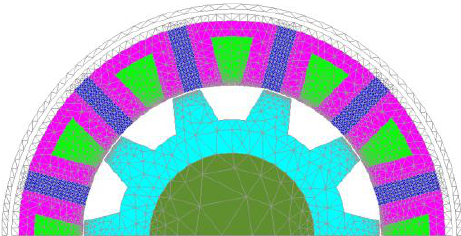
Figure 11. Electromagnetic (EM) field analysis model.